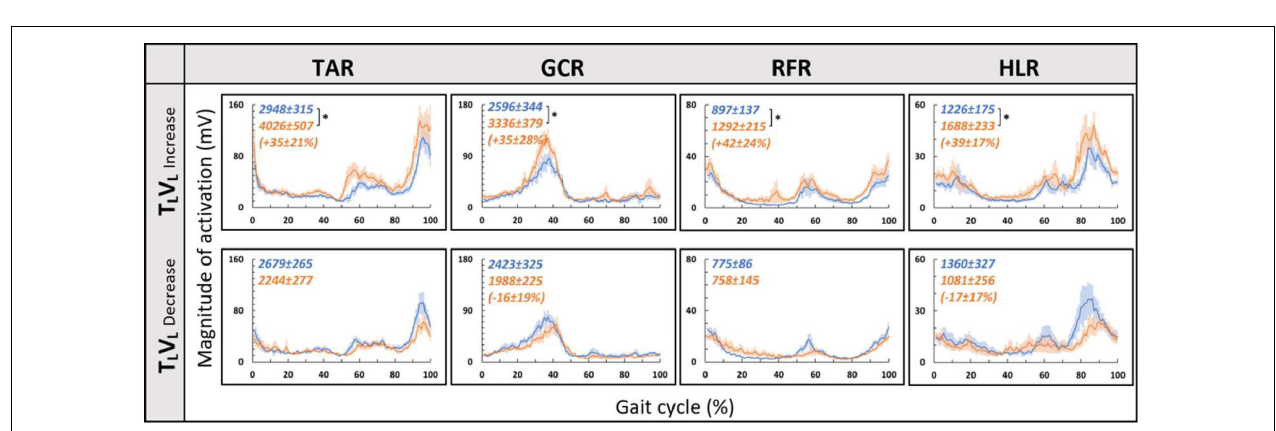
FIGURE 6 | Visual inclinations do not affect muscle activation patterns for uphill (A) or for downhill (B) treadmill inclination. Conventions as in Figure 5 , * p < 0.0125. This demonstrates that patterns of muscle activation during physical uphill walking did not change regardless of conflicting visual cues [panel (A) : top row—uphill vision (+10 ◦ ), bottom row—downhill vision ( − 10 ◦ ); compare orange traces in the first and second rows]. Likewise, patterns of muscle activation during physical downhill walking were not affected by conflicting visual cues [panel (B) : top row—downhill vision ( − 10 ◦ ), bottom row—uphill vision (+10 ◦ ); compare orange traces in the first and second rows].